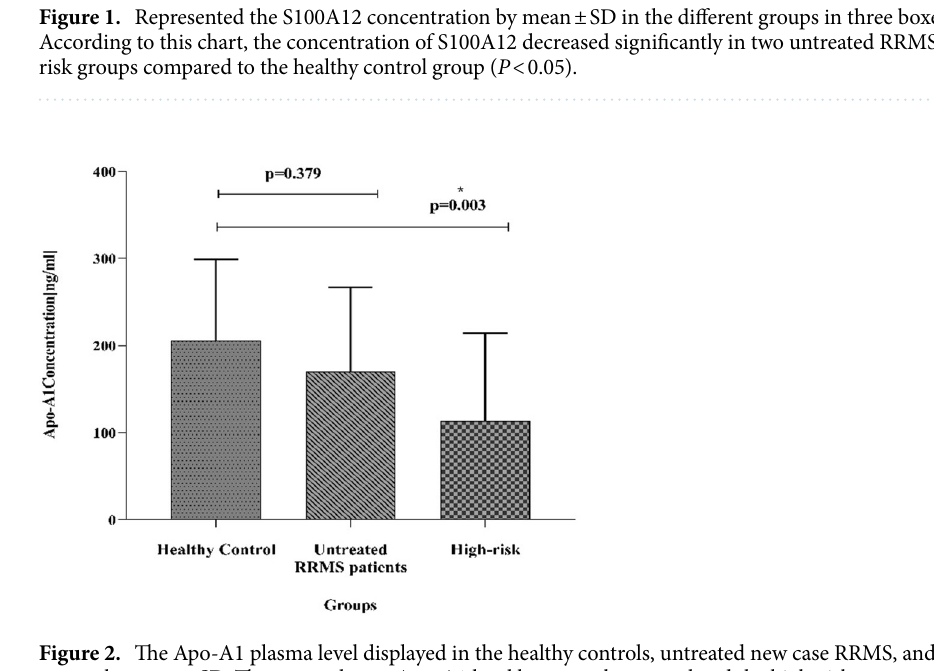
Figure 2. The Apo-A1 plasma level displayed in the healthy controls, untreated new case RRMS, and high-risk groups by mean ± SD. The mean plasma Apo-A1 level between the control and the high-risk groups was reduced markedly ( P = 0.003). The difference between the untreated RRMS and the healthy control groups was presented by the post-hoc test ( P =